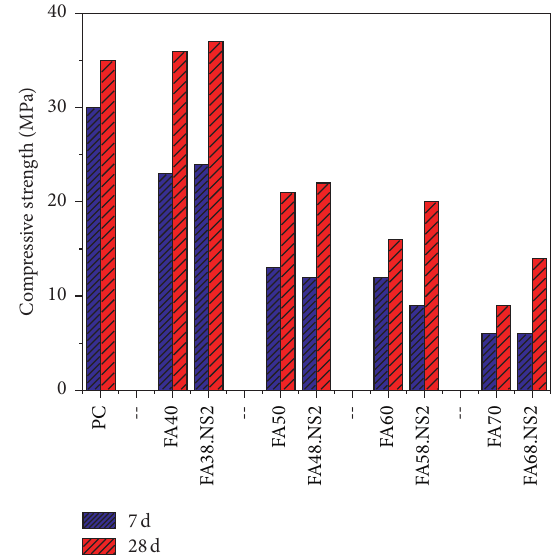
Figure 12: Effects of 2% NS on the compressive strength of mortars containing HVFA [73].